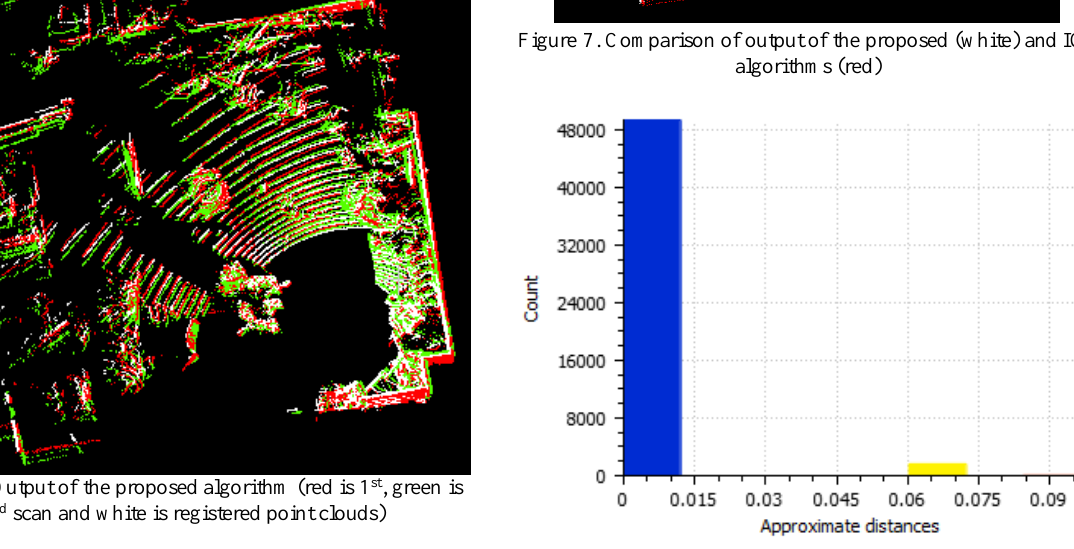
Figure 8-Distribution of distances between output of ICP and the proposed